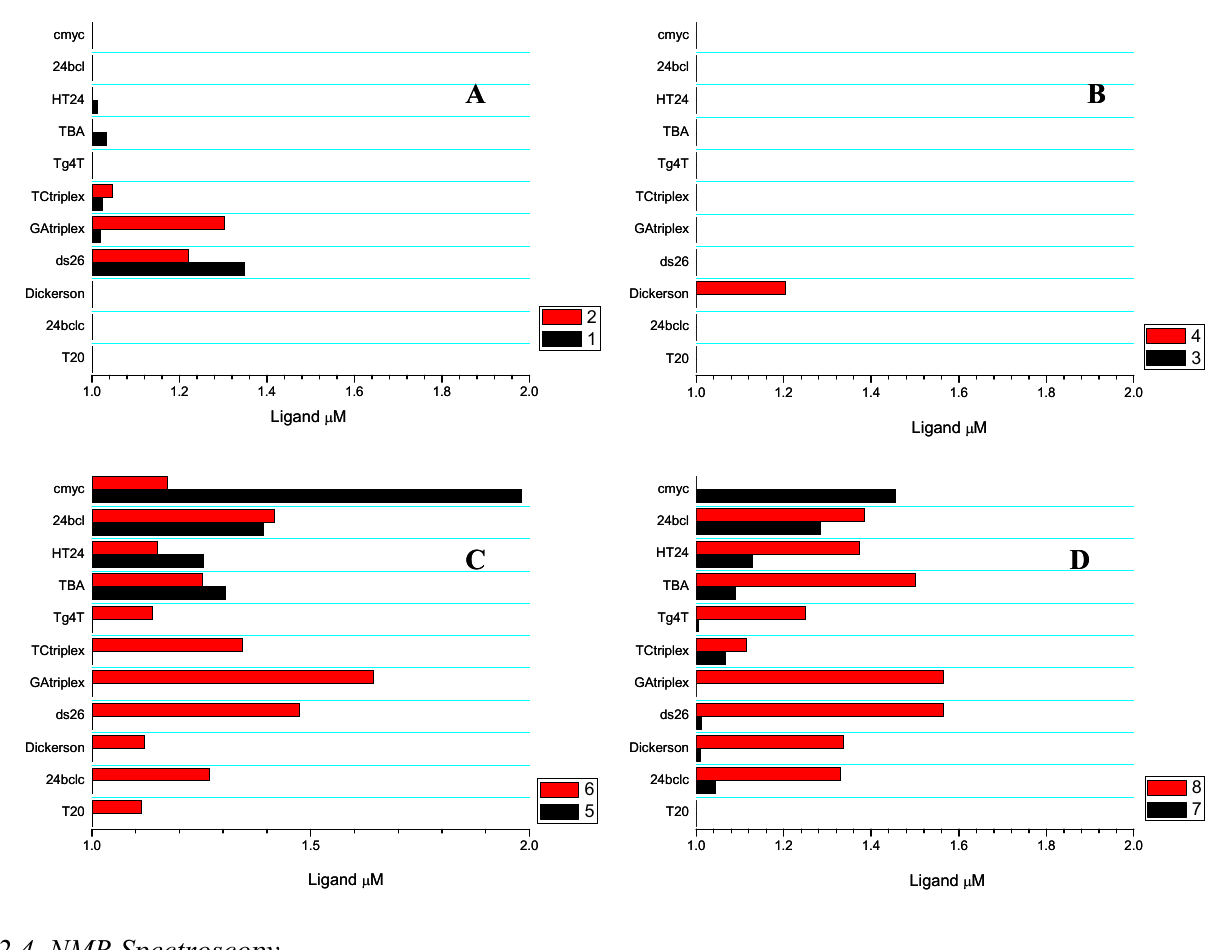
Figure 3. Competitive dialysis assay: The amount of ligand bound to each DNA structure is shown as a bar